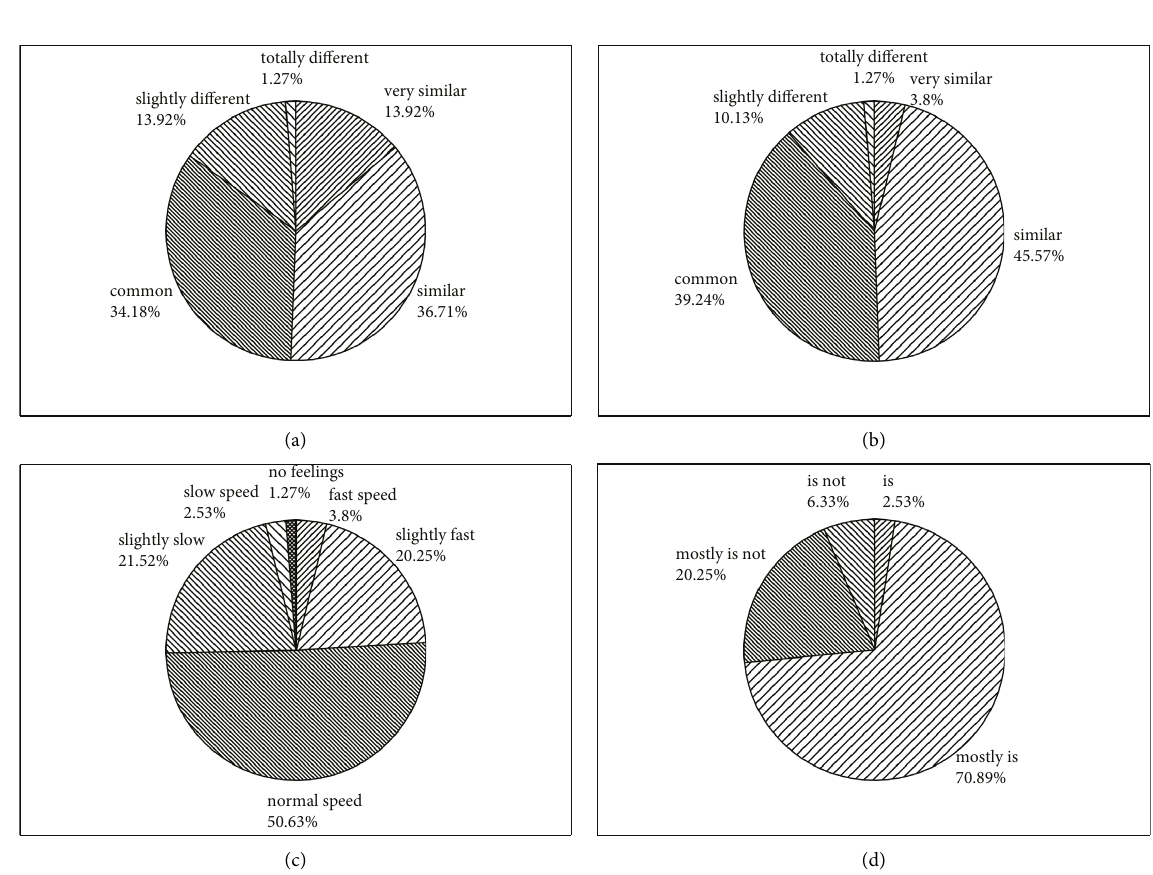
Figure 4: Result analysis of subjective questionnaire. (a). Do you think the experiment environment is similar to the subway (b). Do you think experiment scene is similar to the subway (c). What do you think your walking speed compared with usual (d). Do you see the experiment flow in subway frequently.